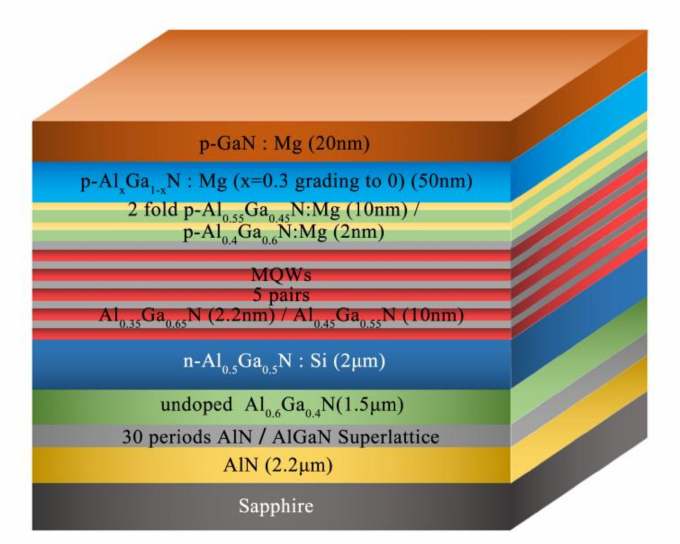
Figure 1. Schematic representation of the epitaxial structure of the AlGaN-based UVB-LED. UVB-LED chips were fabricated using standard flip-chip processing